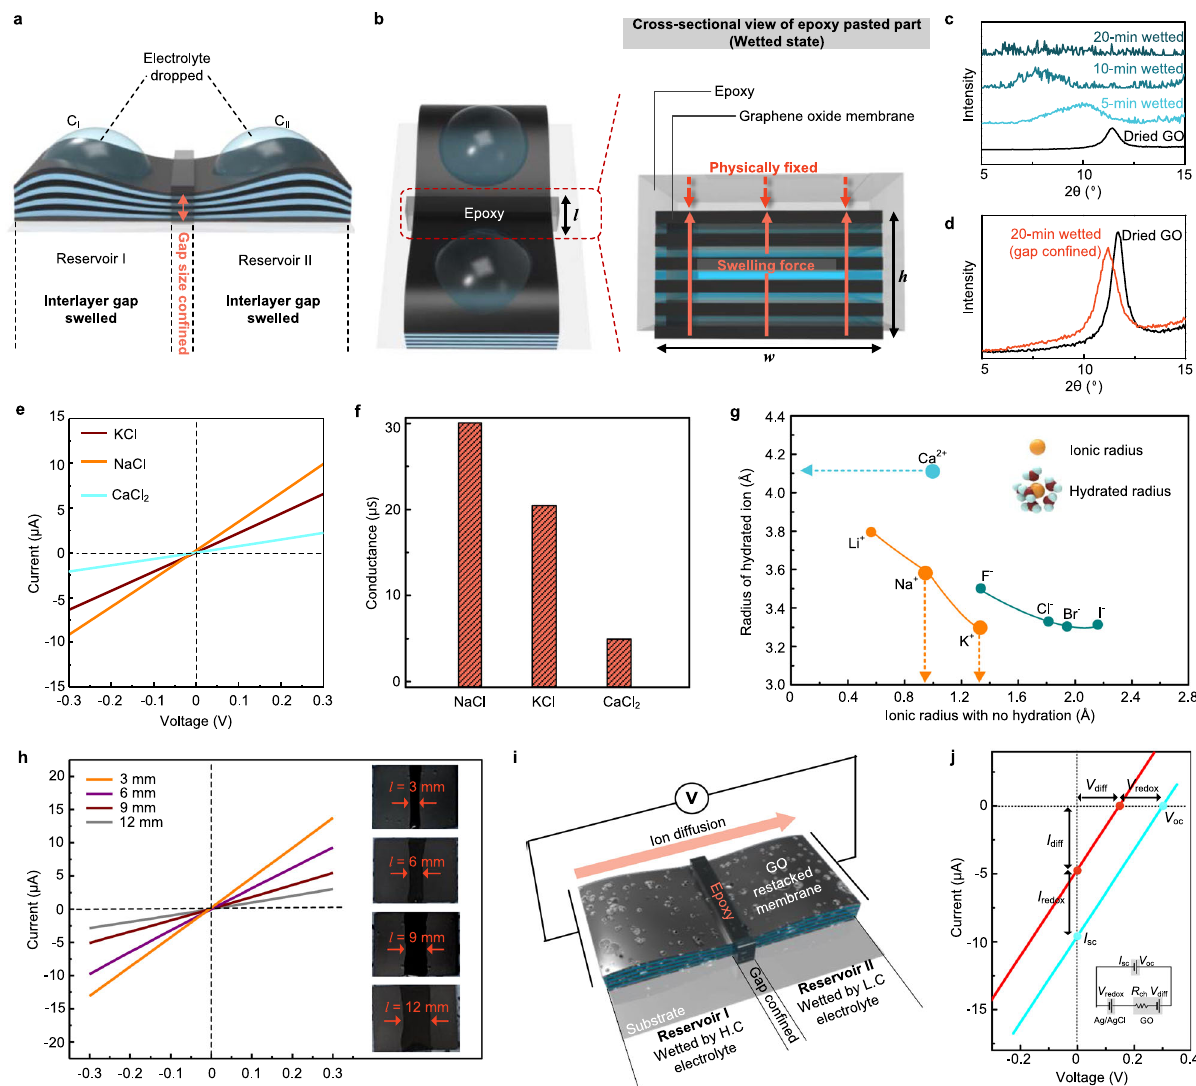
Fig. 2 Ion transport and energy conversion. a Schematic of neuromorphic concentration cell. The graphene oxide membrane is divided into epoxy-pasted part (channel) and non-epoxy-pasted part (reservoir). C I and C II are the electrolyte concentration of reservoir I and II, respectively. b Schematic of physically con fi ned channel by epoxy. l , w , and h are the length, width, and height of the epoxy-pasted part (channel), respectively. c XRD patterns when reservoir parts of GO membrane is wetted by water. d XRD patterns when channel part of GO membrane is wetted. e . I – V curve data without concentration gradient of KCl, NaCl, and CaCl 2 . The concentration of each solution is 0.1 M. f Ionic conductance value of GO membrane as a function of types of cation. g Size distribution of ions that are hydrated and not hydrated. h Ionic conductance of GO membrane as a function of length of epoxy-pasted part. i Schematic of ion diffusion direction when concentration gradient is applied. j I – V curve data under a concentration gradient of 10 3 across the channel. The value by ion-selective diffusion (red line) is obtained by subtracting the redox reaction of the electrode by the unequal chloride ion concentration at the measured value (blue line). V oc , I sc , V diff , and I diff are the open-circuit voltage, short-circuit current, diffusion voltage, and diffusion current, respectively. V I redox and redox are the voltage and current from redox reaction of the